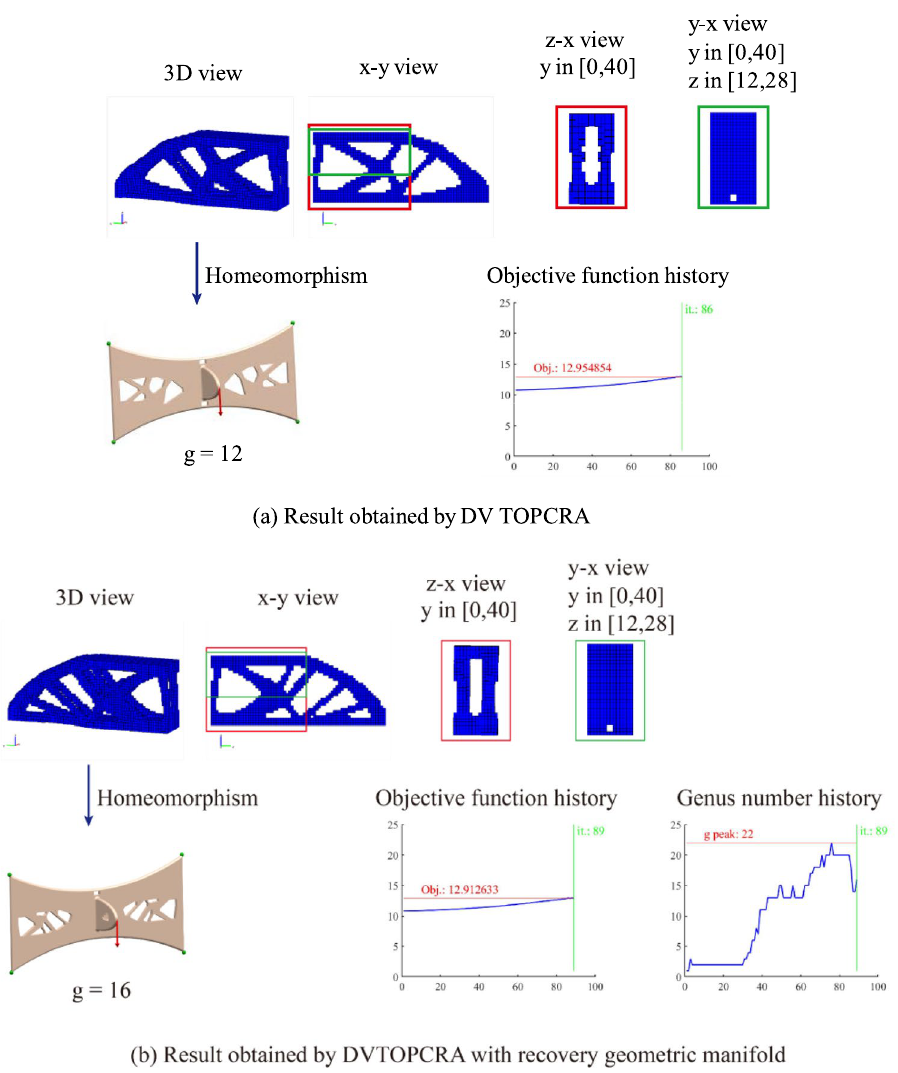
Figure 7. ( a ) Results obtained by DVTOCRA. ( b ) Results obtained by DVTOCRA with a recovery geometric manifold. In the homeomorphism graph, the green dots represent displacement constraints, and the red arrow represents the